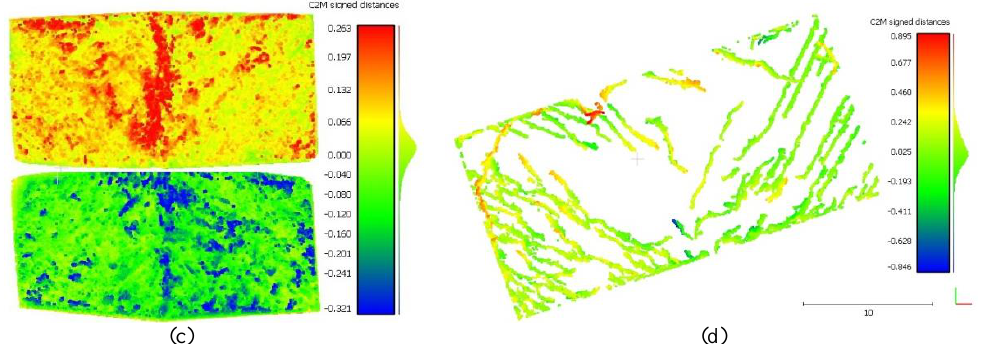
Figure 10. The Hausdorff distances calculated for the roof UAS point clouds obtained by different software: Zephyr (a), PhotoModeler Scanner (b), Drones2Map (top view and bottom up view) (c) and Visual SfM (d),using as reference data the mesh created based on GNSS measurements